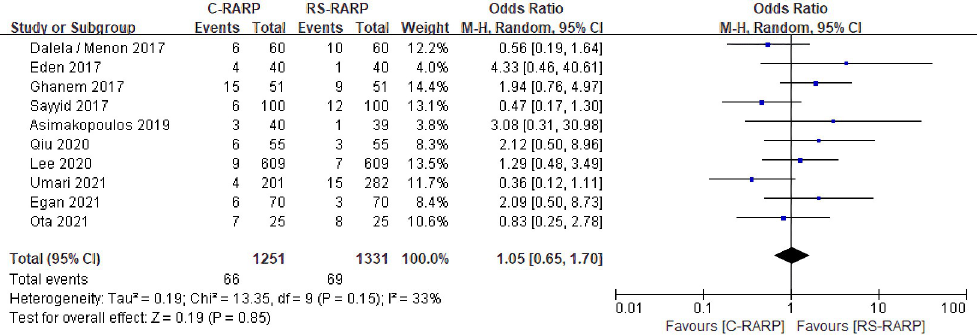
Fig 6. Forest plots of